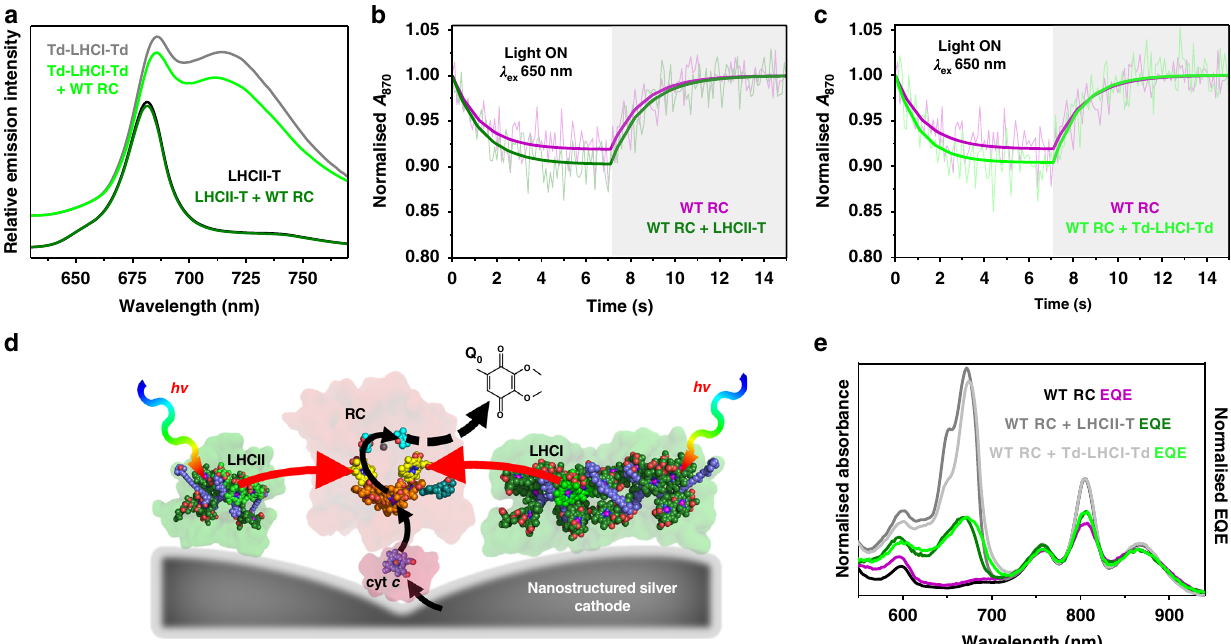
Fig. 2 Energy transfer requires co-localisation of RCs and LHCs. a LHCII emission (excitation at 475 nm) and LHCI emission (excitation at 500 nm) in the absence and presence of WT RCs. The latter spectra are offset for clarity. b Data and fi ts for photobleaching and dark recovery of P870 absorbance for the WT RC in the absence and presence of LHCII (using variant LHCII-T). c Photobleaching and dark recovery of P870 absorbance in WT RCs in the absence and presence of LHCI (using variant Td-LHCI-Td). d Schematic of photocurrent generation on a nanostructured silver electrode; black arrows show the route of electron transfer and red arrows show energy fl ow. e Solution absorbance and EQE spectra for WT RCs compared with those for mixtures of WT RCs with either LHCII-T or Td-LHCI-Td. The absorbance spectra were normalised at 804 nm, while each EQE spectrum was normalised to the corresponding absorbance spectrum at the maximum of the long-wavelength P870 Td-dLHCII) or the full SpyTag sequence added to the C-terminus of the full Lhcb1 (termed LHCII-T) (Fig. 3b).